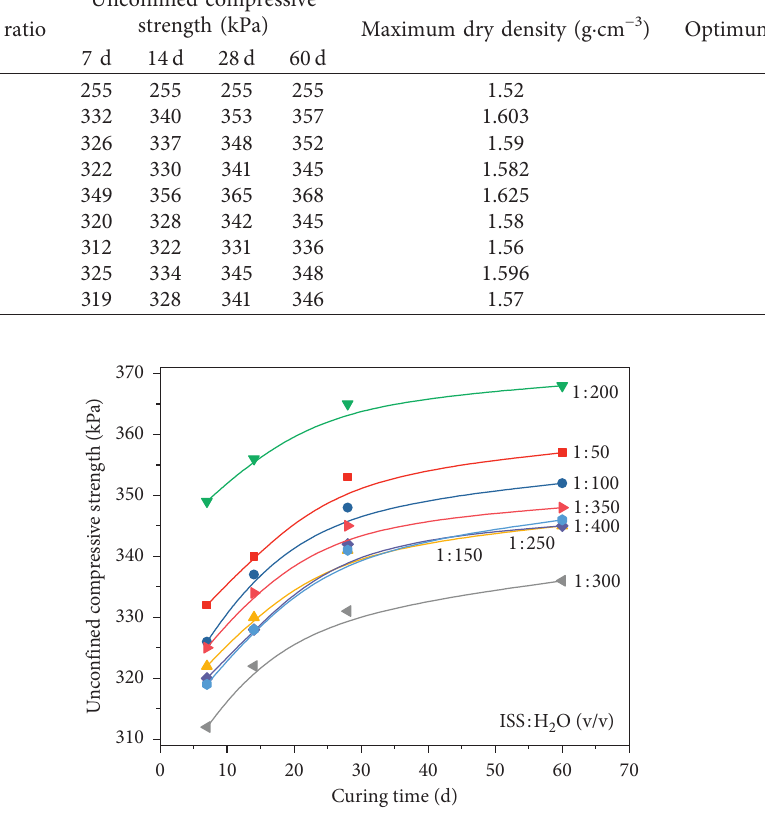
Table 5: The unconfined compressive strength of red clay with different ISS/H Sample